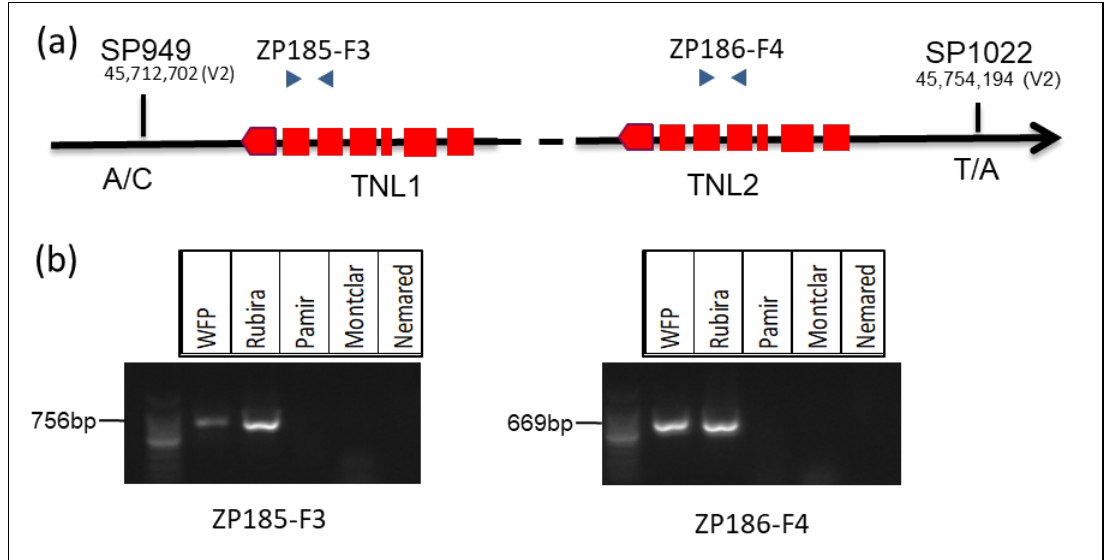
Figure 6. Genotyping with the two primers ZP185F1R1 and ZP185F3R3 specific of the TNL1 gene, of the Rubira cDNA and Weeping flower peach (WFP) cDNA and DNA.